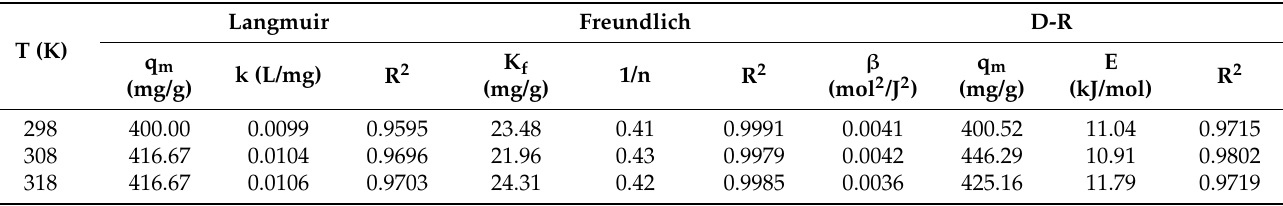
Table 4. The maximum phosphorus adsorption capacities reported in